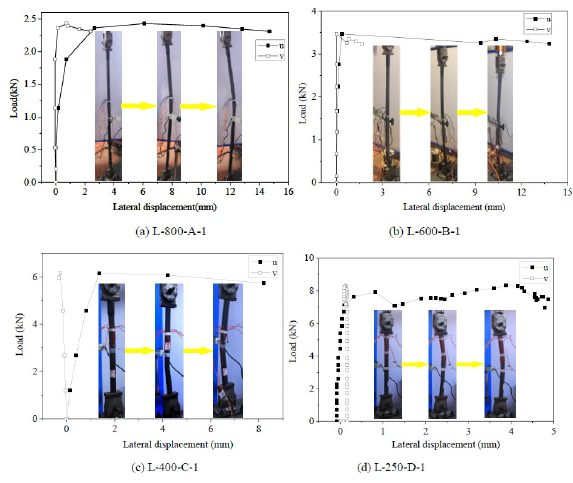
Figure 5: Load-lateral displacement curves for tubes with different